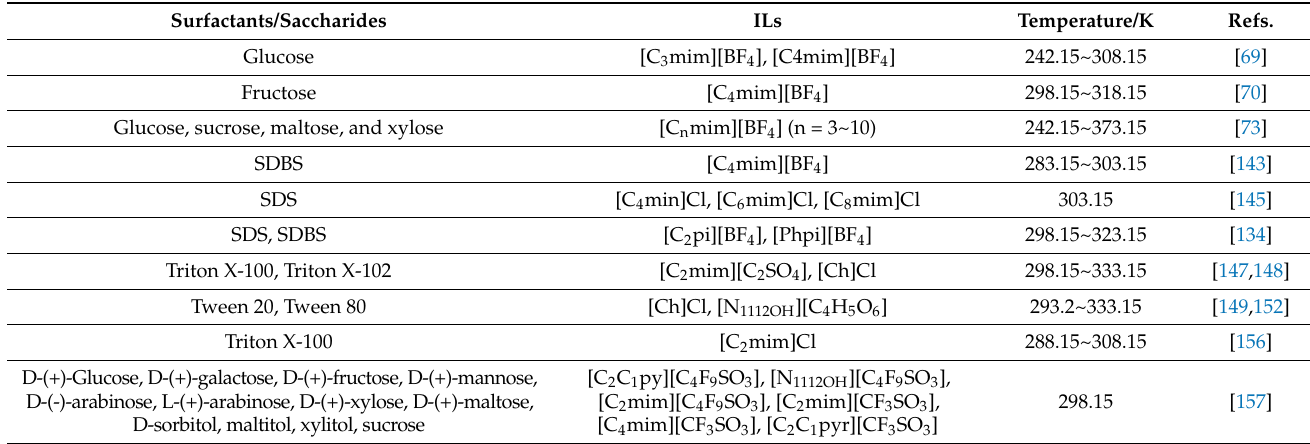
Table 3. Some surfactants/saccharides commonly used in the IL-based